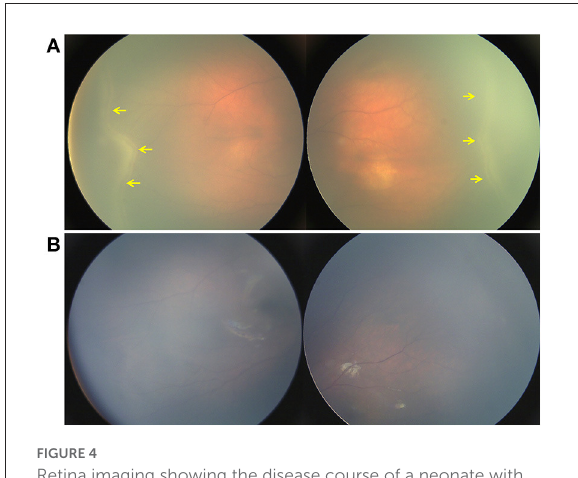
FIGURE4 Retina imaging showing the disease course of a neonate with ROPLR (GA 37W, BW 2500g, IVD 37W + 3 ). (A) Fundus picture showing retinal ridges and peripheral neovascularization (yellow arrow) in zone II in bilateral eyes. (B) Fundus images of both eyes showing that the ridges resolved spontaneously 2 months after the first visit. Neither vessel dilation nor tortuosity was